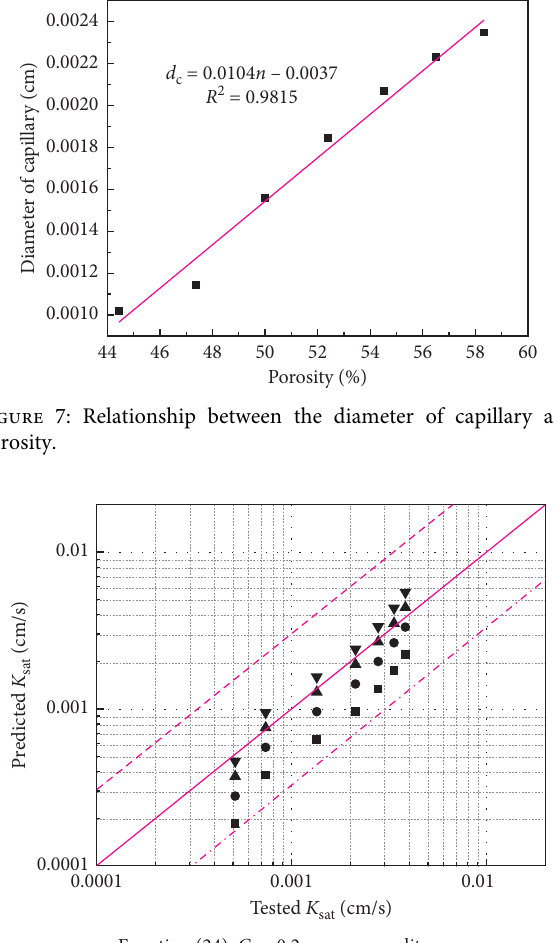
sat values for different pore